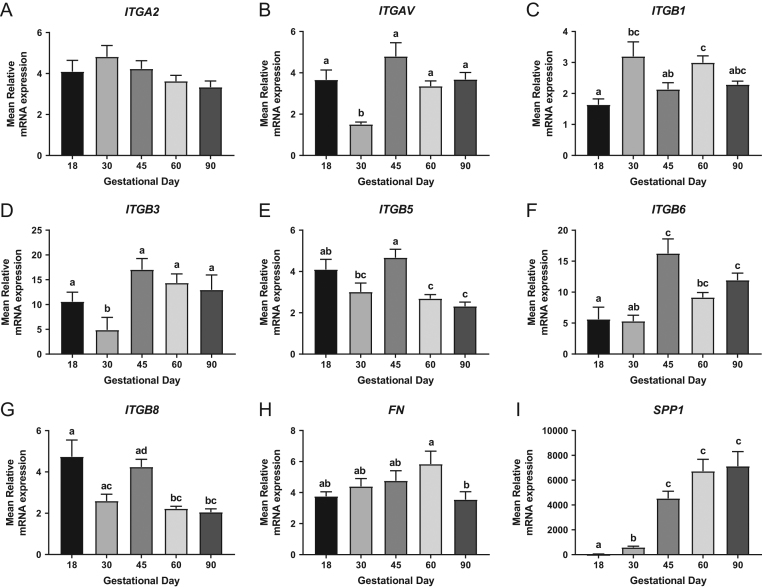
Integrin mRNA expression in endometrial tissues on days 18, 30, 45, 60 and 90 of pregnancy. mRNA expression of ITGA2 (A), ITGAV (B), ITGB1 (C), ITGB3 (D), ITGB5 (E), ITGB6 (F), ITGB8 (G), FN (H) and SPP1 (I) in endometrial samples at GD18, 30, 45, 60 and 90. Error bars represent s.e.m. n = 9–30 foetuses/GD.